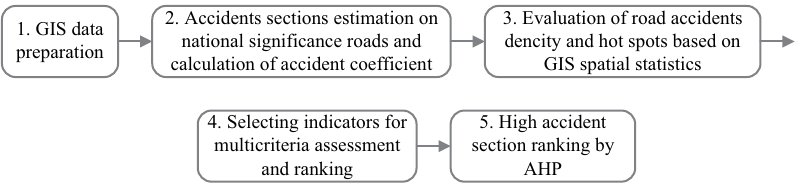
Figure 2. Steps of accidents analysis and